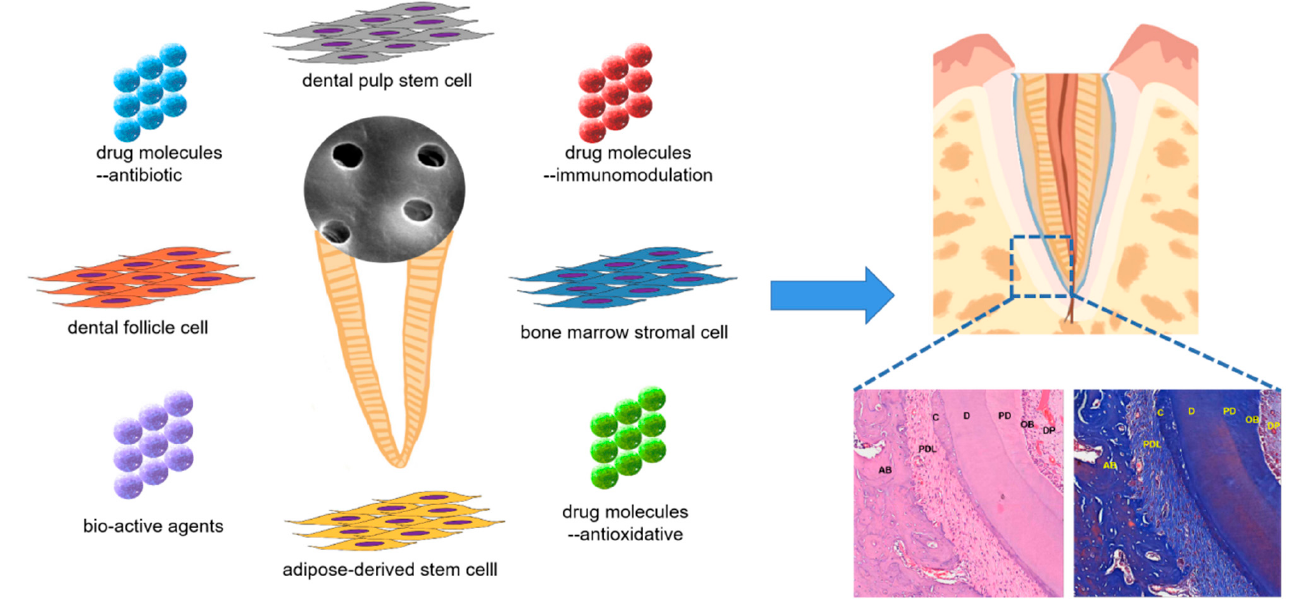
Figure 4. Treated-dentin-matrix-based bio-root construction. AB: alveolar bone, PDL: periodontal ligament, C: cementum, D: dentin, PD: pre-dentin, OB: odontoblast, DP: dental pulp. Table 6. Treated dentin matrix and its derivatives for bio-root construction.